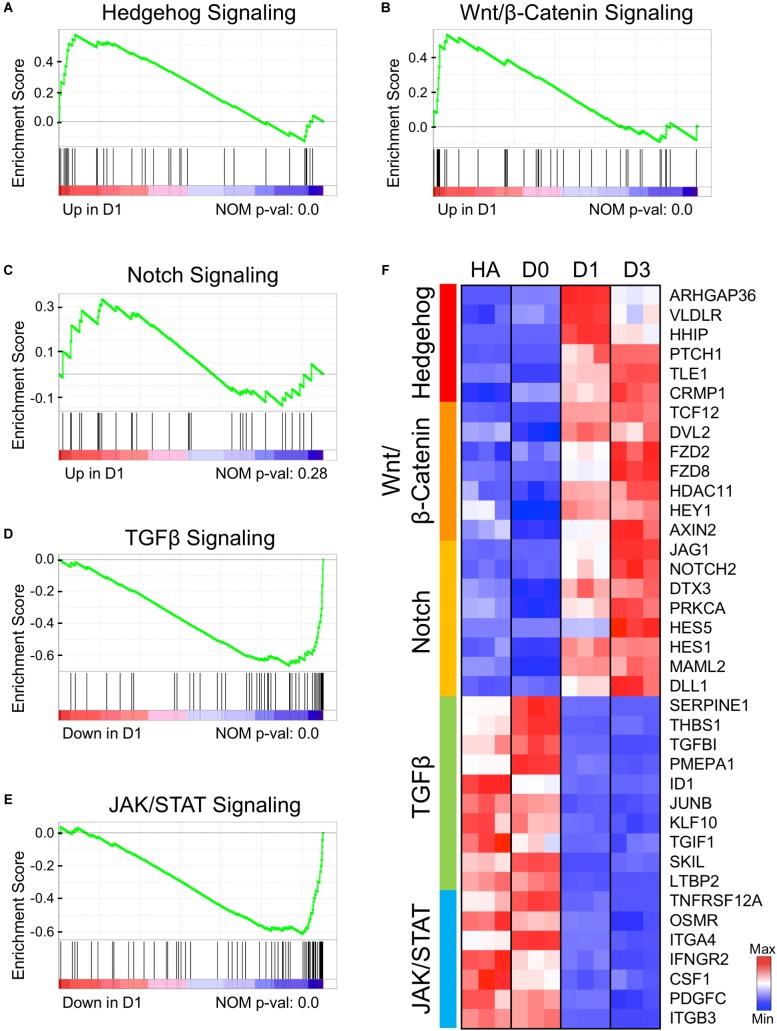
Early genetic alternations of signaling pathways in response to core drug treatment. (A–E) Gene set enrichment analysis (GSEA) of D1 samples compared to HAs revealed several signaling pathways that were either activated (A–C) or suppressed (D,E) at the initiation stage of chemical reprogramming. (F) Heat map illustrating the leading-edge subsets of genes corresponding to each signaling pathway shown in (A–E). Color scaled within each row. Red color indicates high expression level, while blue color indicates low expression level.